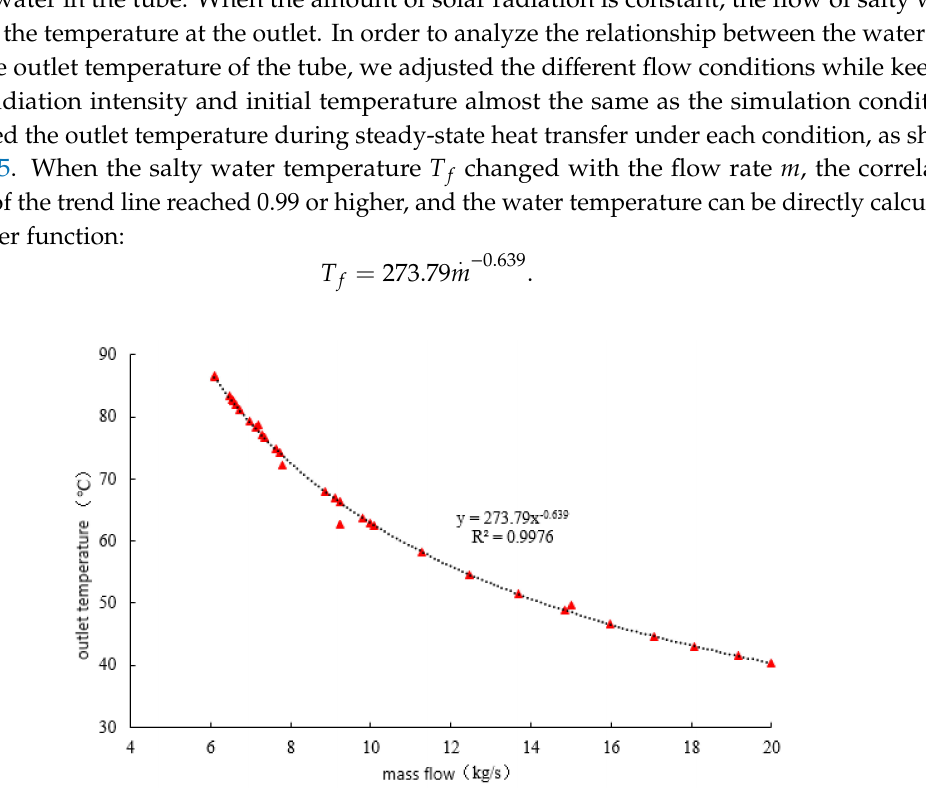
Figure 15. Curve of outlet temperature and mass flow